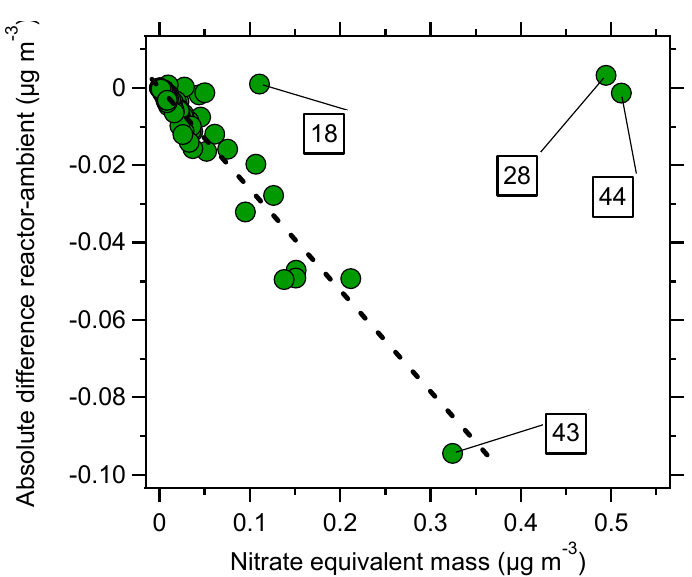
Figure 1. Typical time series from the campaign showing scanning mobility particle sizer (SMPS) volume and number concentrations, O:C and H:C elemental ratios and chemically resolved mass concentration (NO 3 and NH 4 are offset a factor 5 for clarity). Reactor measurements, highlighted in light blue gives lower volume and number concentrations, but higher O:C. Organics and nitrate is lost while sulphate is not affected.